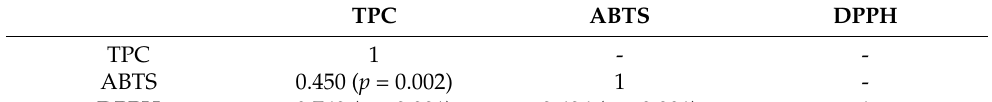
Table 5. The Pearson’s correlation coefficients between the TPC, ABTS, and DPPH in 23 vine shoot extracts.